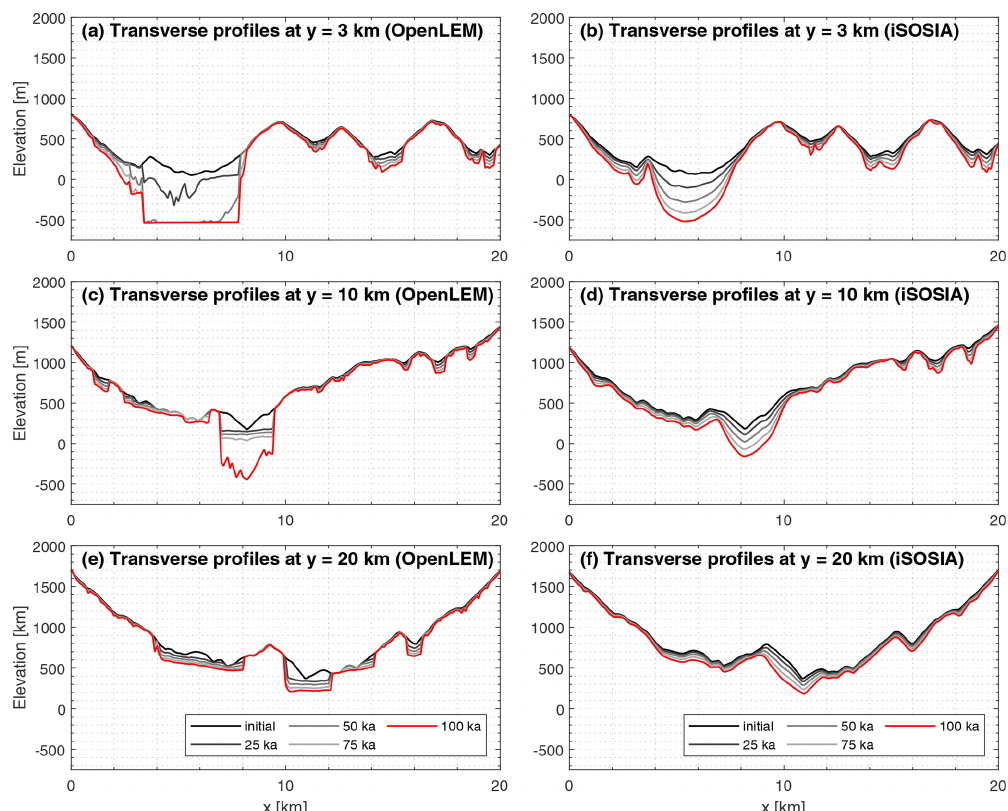
Figure B1. Time series of the evolution of the transverse profiles in the OpenLEM and iSOSIA experiment (Sect. 3.1) at 3, 10 and 20km upstream of the longitudinal swath profile.